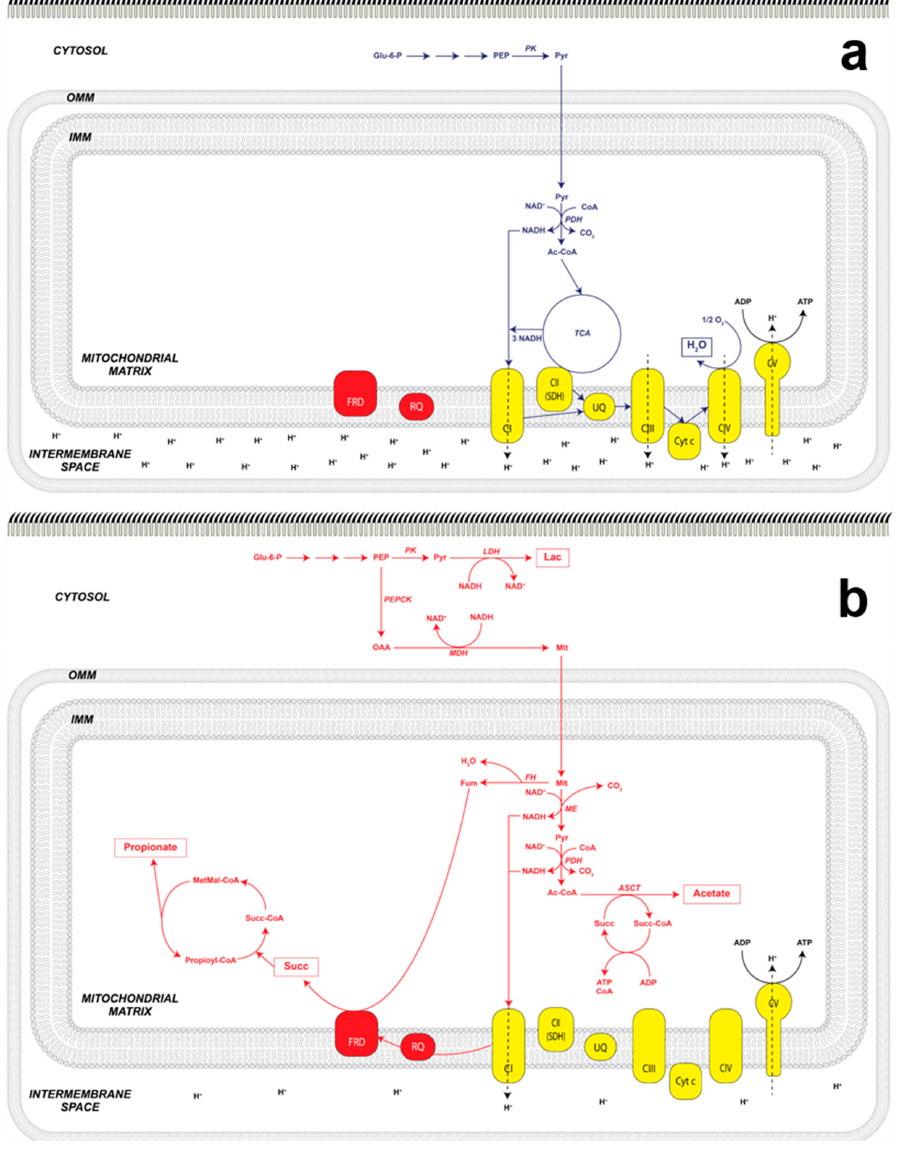
Figure 4. Aerobic and anaerobic energy metabolism in parasitic flatworms. Representation of the electron flow in aerobic metabolism: Panel ( a ), while Panel ( b ), represents the electron flow corre-